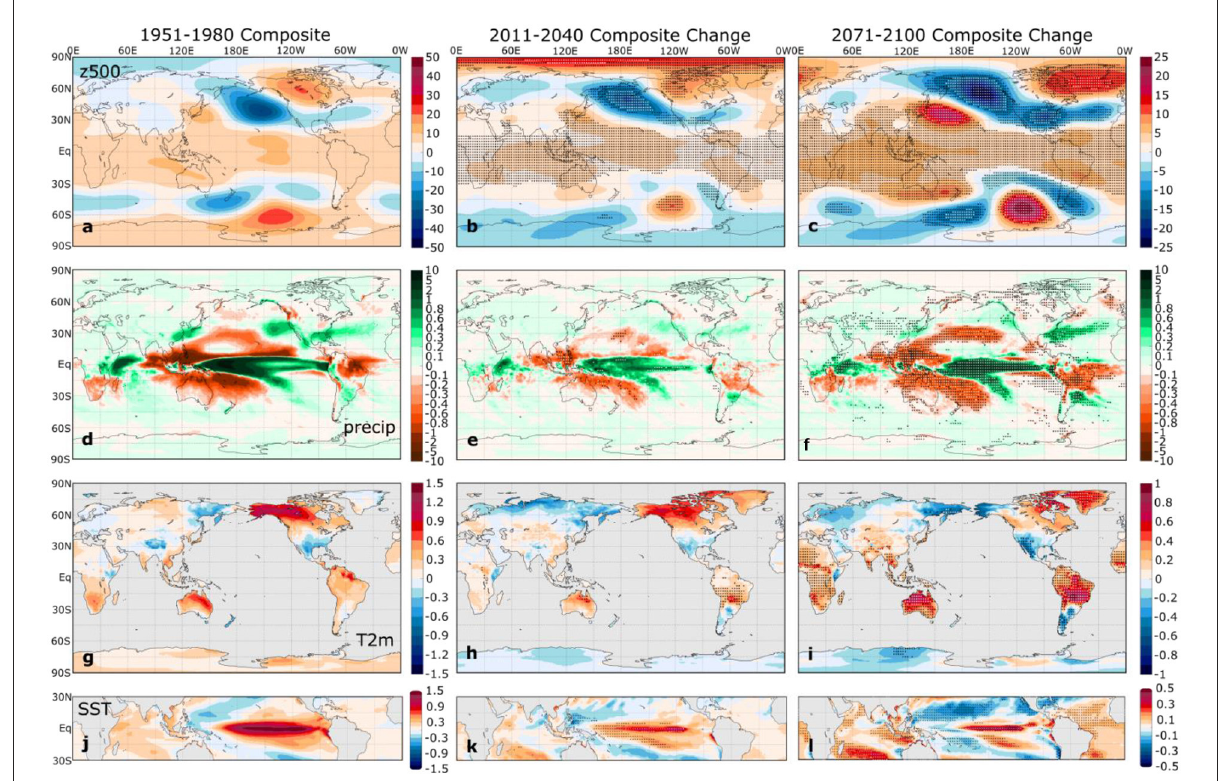
FIGURE3 (Left) ensemble mean SPEAR DJF El Niño composites of (a) 500 hPa geopotential height (m), (d) precipitation (mm d − 1 ), (g) T2m ( ◦ C), and (j) SST ( ◦ C) anomalies for the 1951–1980 period. The middle and right columns show the corresponding ensemble mean composite (b,c) z500, (e,f) precipitation, (h,i) T2m, and (k,l) SST changes in (middle) 2011-2040 and (right) 2071-2100 relative to the 1951–1980 base period. Stippling in the middle and right columns indicates ensemble mean statistically significant composite changes that control the false discovery rate at the 10% level based on a two-sided t -test. The colorbars in the left column apply to the 1951–1980 composites, and the colorbars on the right side apply to the middle and right